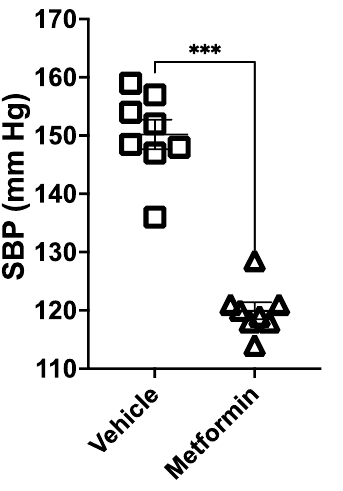
Figure 1. Metformin alleviates systolic blood pressure measurements in diabetic db/db mice on a high salt diet (HSD). The tail-cuff method was used to measure blood pressure in male and female salt-loaded diabetic db/db mice maintained on an HSD and treated with vehicle or metformin. N = 8. Data are plotted as mean ± SEM, and *** represents a p -value <